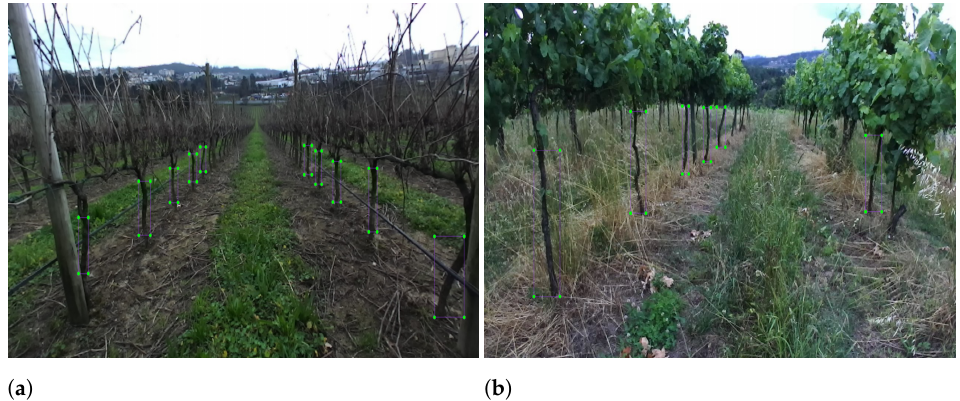
Figure 6. The result of the annotation process for trunk detection in two different vineyards repre- sented in ( a , b ). The green dots represent the extremes of the annotated bounding boxes that contain the vineyard